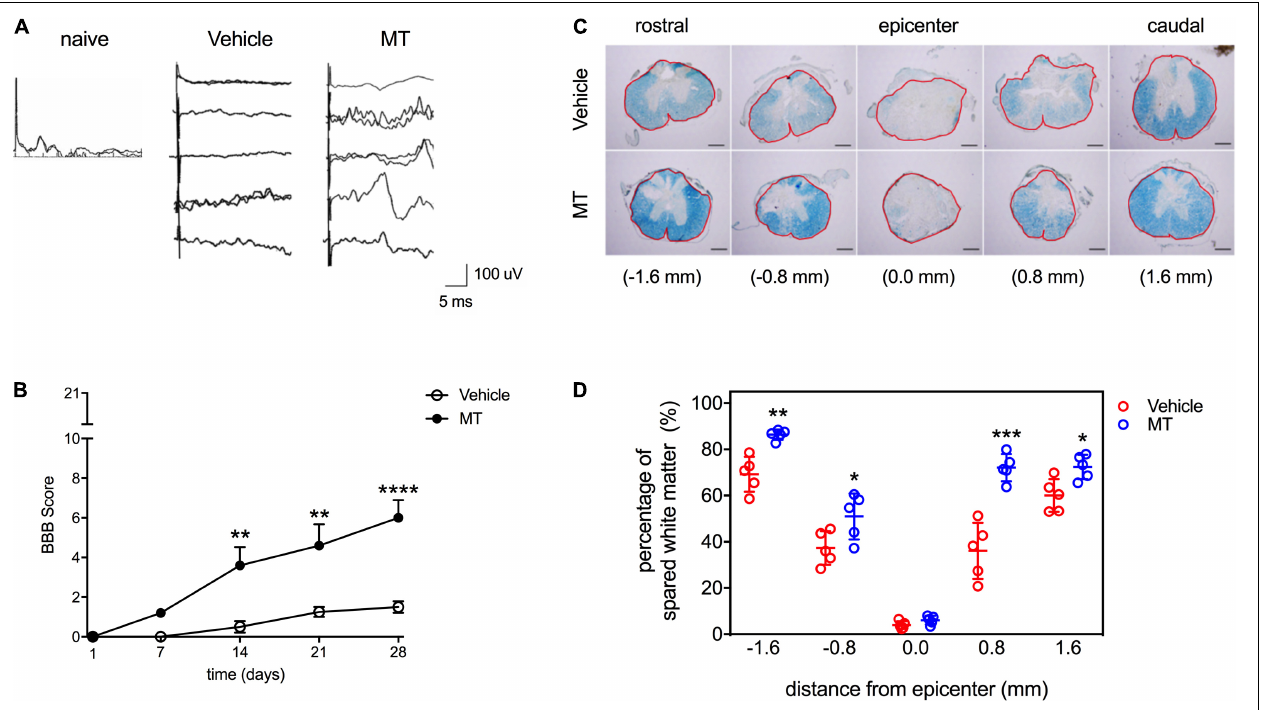
FIGURE 2 | Effects of mitochondrial transplantation on the sensory and locomotor functions and the white matter sparing in the injured spinal cord of rats with traumatic SCI. (A) Representative micrographs of SSEP traces recorded in SCI rats on PID 28. Scale = 100 µ V/5 ms (B) Quantitative results of BBB scoring. ** p < 0.01, **** p < 0.0001, Sidak’s multiple comparisons performed after the repeated measures two-way ANOVA. (C) Representative micrographs of LFB staining of transverse sections prepared from the injured spinal cords of rats. Scale bar = 100 µ m. The red frames indicated the analyzed areas. (D) Quantitative results of percentage of LFB-positive area. * p < 0.05, ** p < 0.01, *** p < 0.001, two-tailed Student’s t -test. Data were expressed as mean ± standard deviation. N = 5. MT: mitochondria